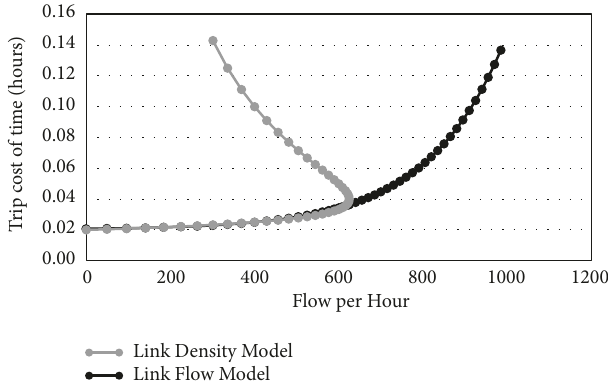
Figure 5: Flow-Delay Curves for Flow-Based and Density-Based Approaches.